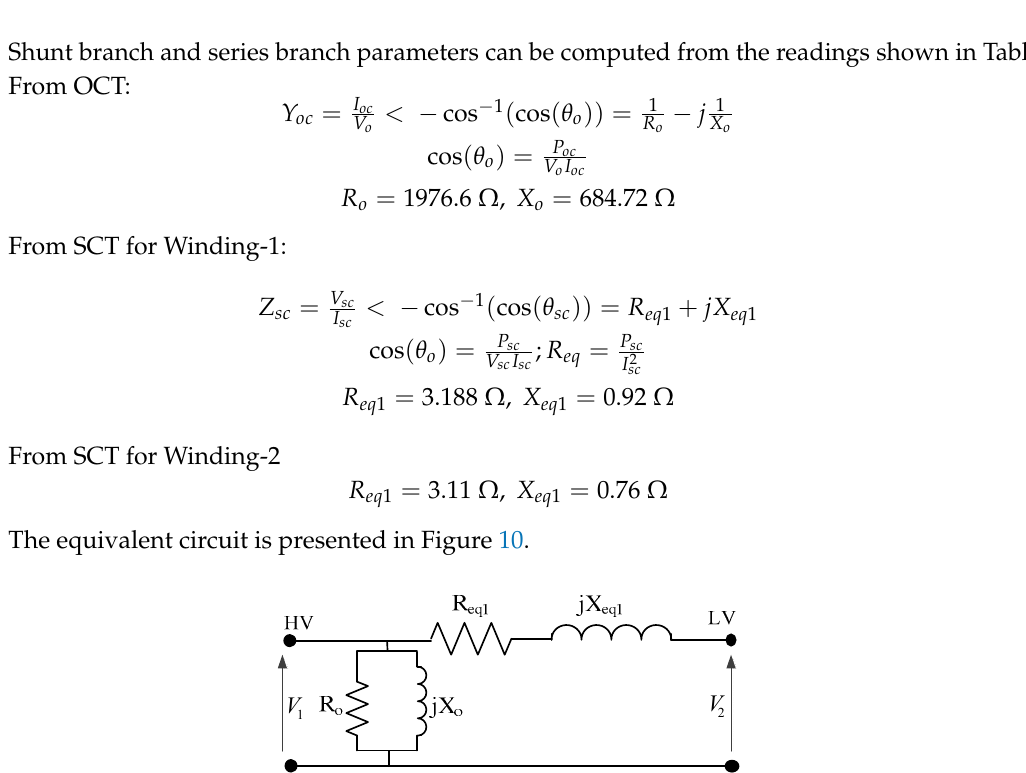
Figure 10. Equivalent circuit of single-phase transformer for fundamental frequency.